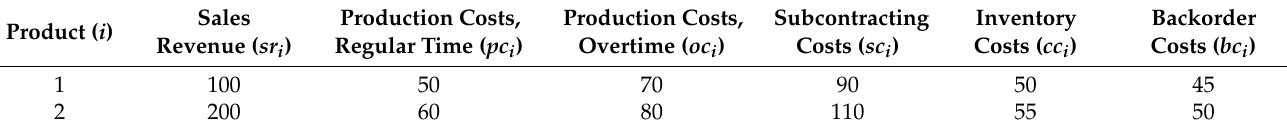
Table 1. Sales Revenue and Production Costs.